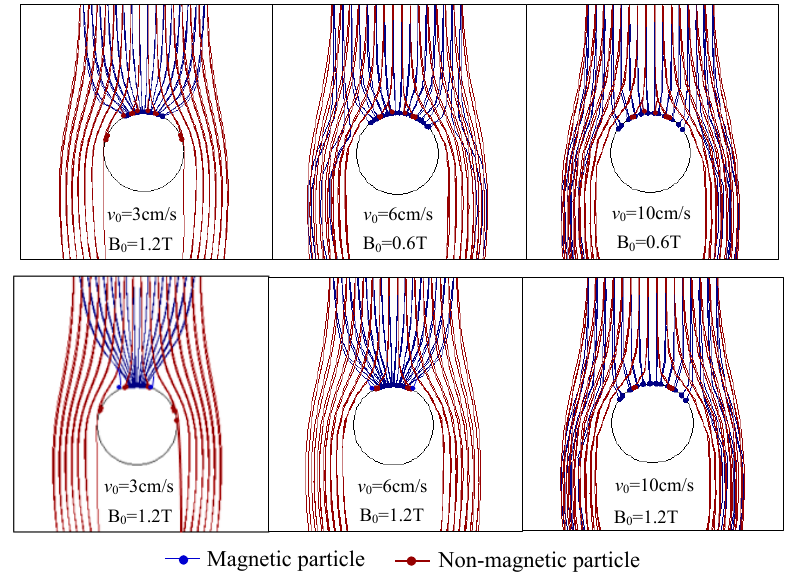
Figure 3. Simulated trajectories of interactive particles in capture of single-wire.